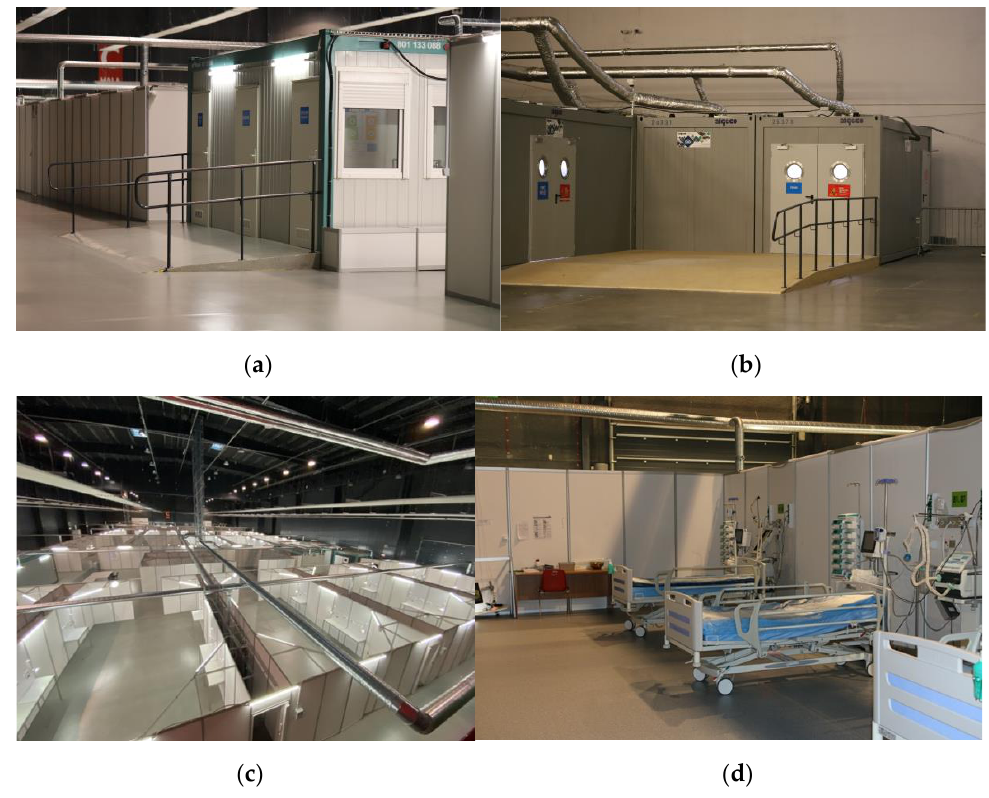
Figure 4. ( a ) Container-type sanitary rooms (e.g., toilets for patients); ( b ) view of the casualty ward; ( c ) top view of the temporary hospital room arrangement and ( d ) view of one of the patient rooms (photo: Agnieszka Gebczynska-Janowicz).